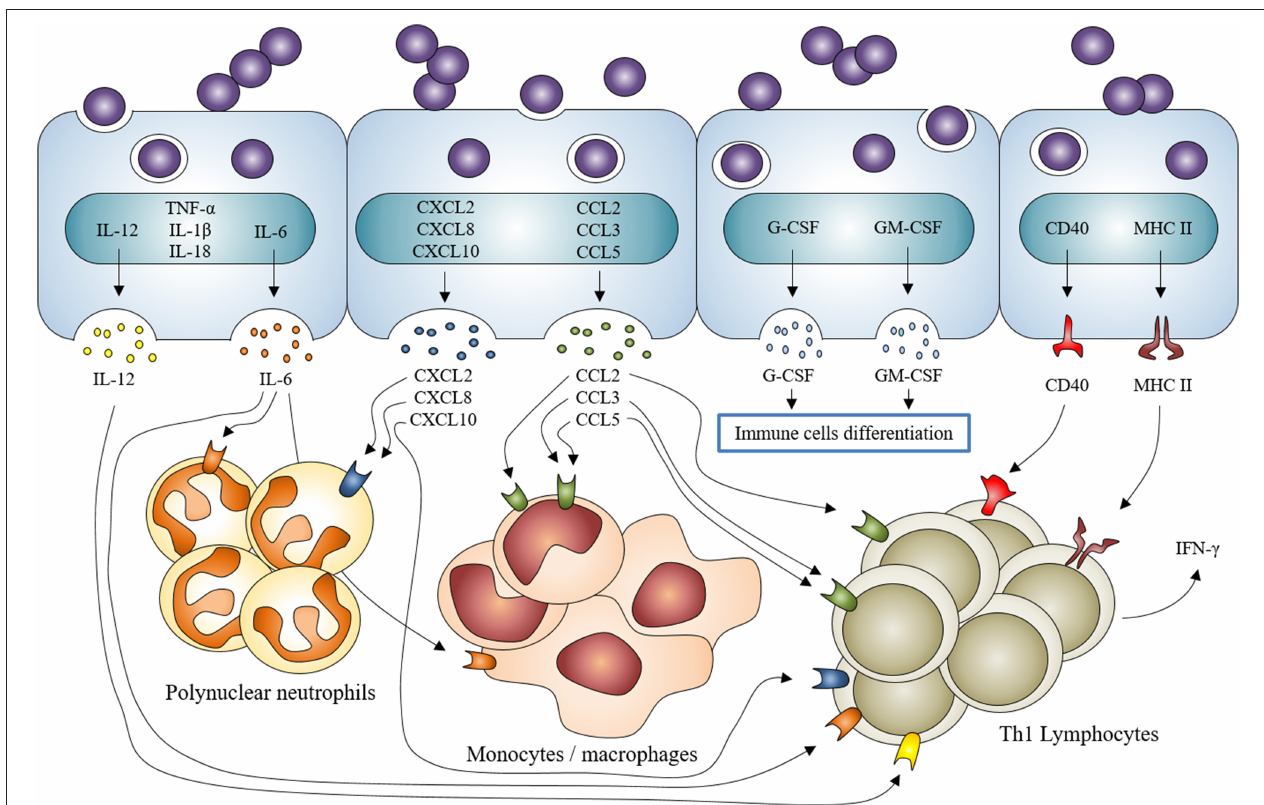
FIGURE 3 | Staphylococcus aureus induction of inflammatory mediator production by osteoblasts and participation in the recruitment/activation of innate and adaptive immune cells. Staphylococcus aureus interaction with osteoblasts increases the expression of cytokines IL-1 β , IL-18, TNF- α , the production and release of IL-6, IL-12 and the expression and release of chemokines CXCL2, CXCL8, CXCL10, CCL2, CCL3, CCL5 and growth factors G-CSF and GM-CSF. It also increases the expression and production of CD40 and MHC II. All of this participates to the recruitment and activation of innate (neutrophils, monocytes/macrophages) and adaptive (lymphocytes) immune